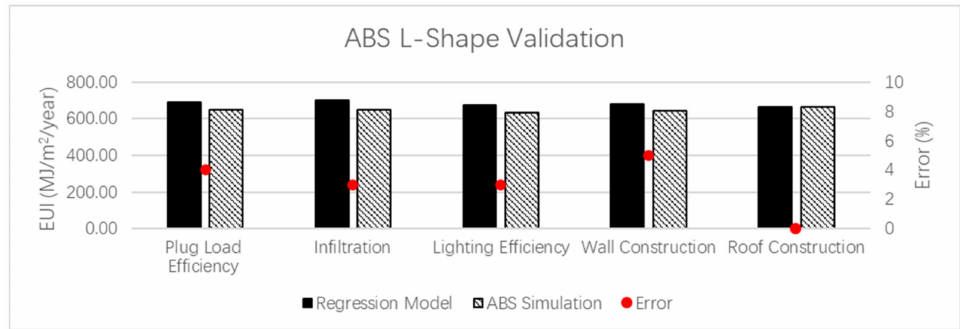
Figure 13. ABS Case study validation—L